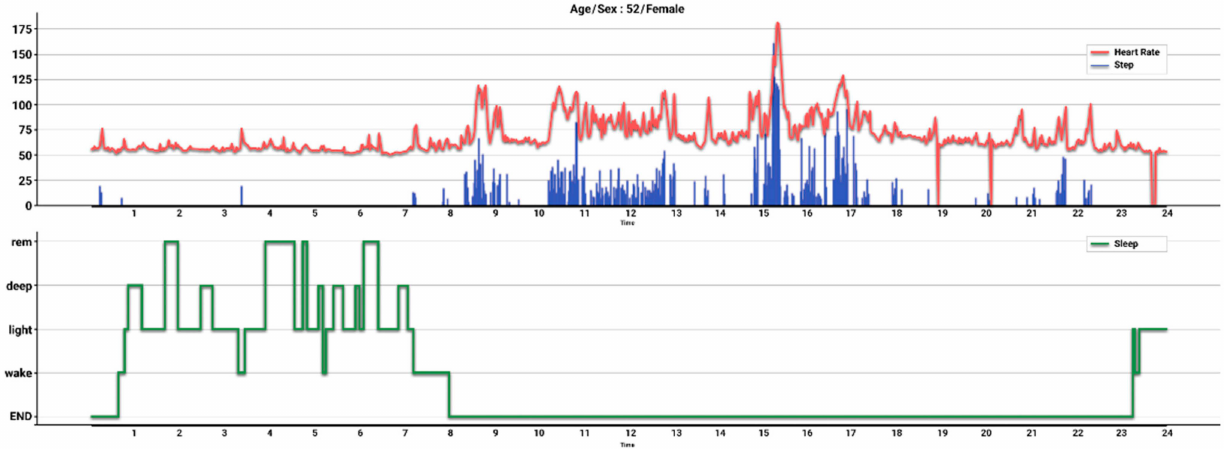
Figure 1. Steps, heart rate, and sleep cycle in a day, as collected by the Fitbit ® device, of a female participant aged 52 years. Schemes follow the same formatting. Indicated are steps (blue line), heart rate (red line), and sleep cycle (green line) with sleep/wake time and four stages of sleep: “wake,” “light,” “deep,” and “REM”.